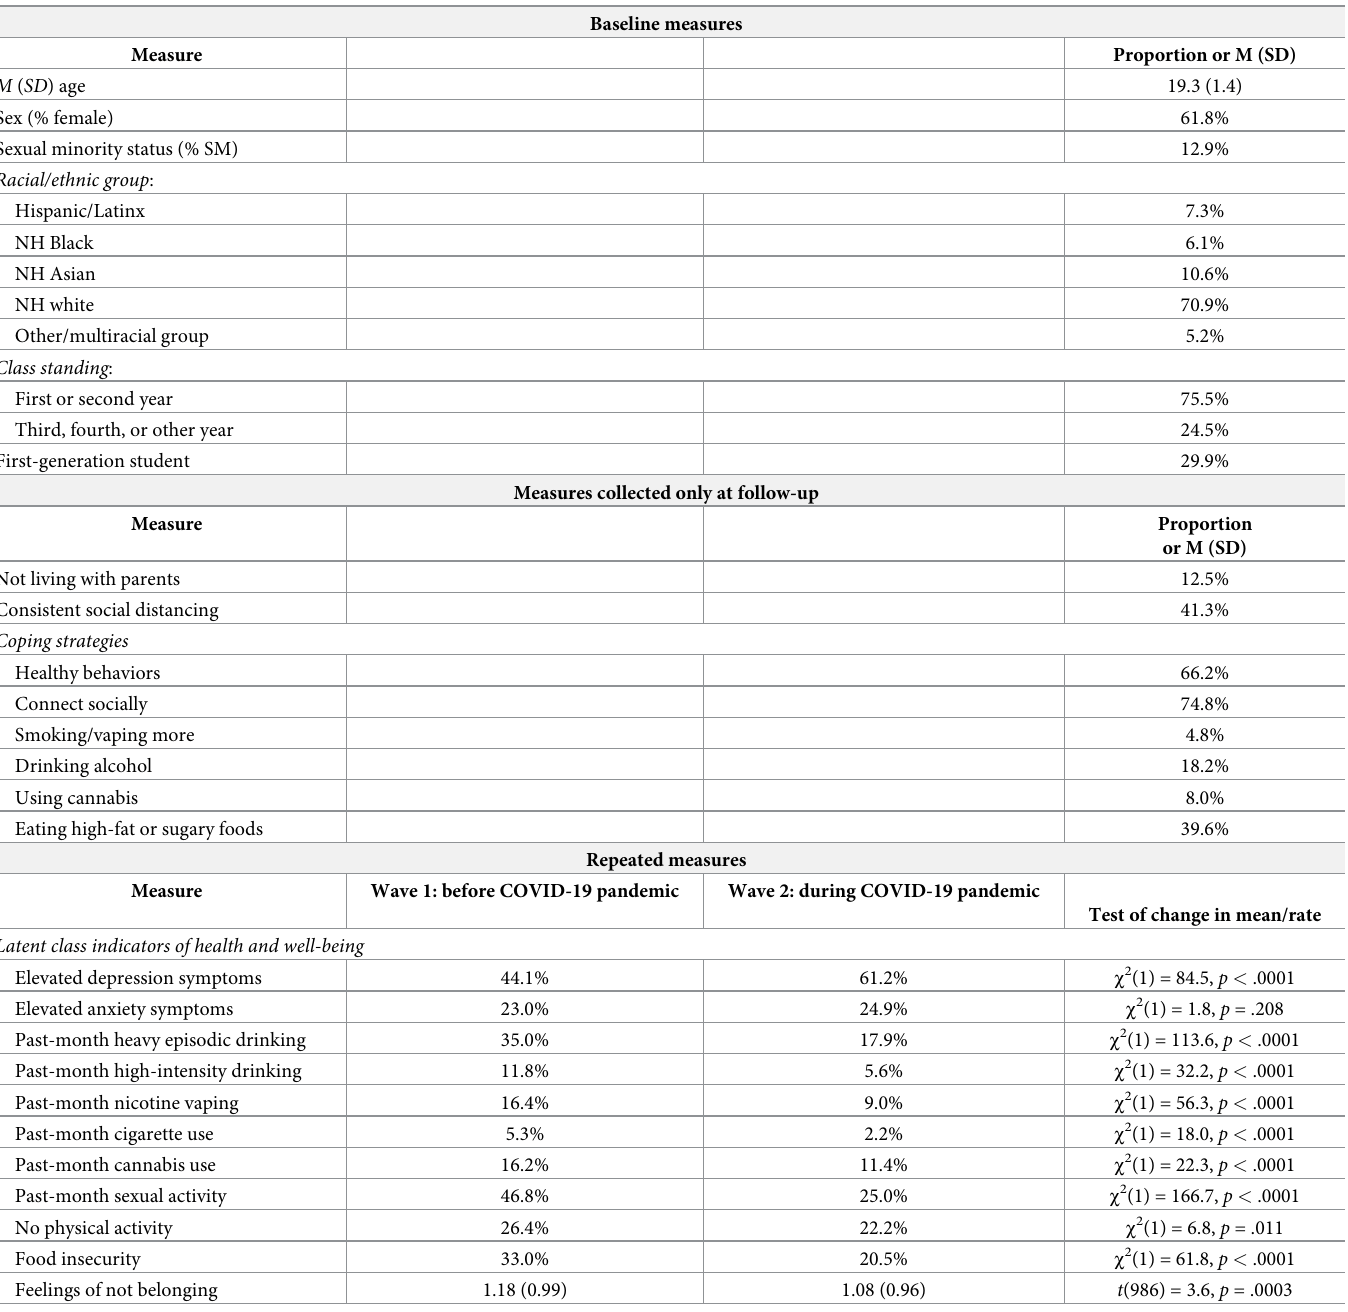
Table 1. Descriptive statistics and tests of change in individual health and well-being indicators ( n = 1,004).